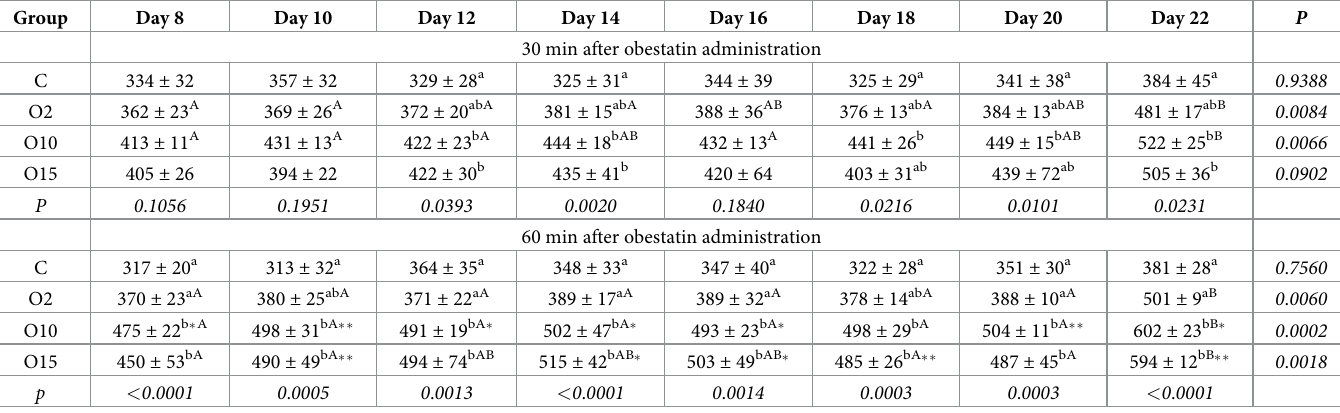
Table 1. The effect of enteral obestatin administration on obestatin concentration [pg/mL] in the blood plasma of piglets.